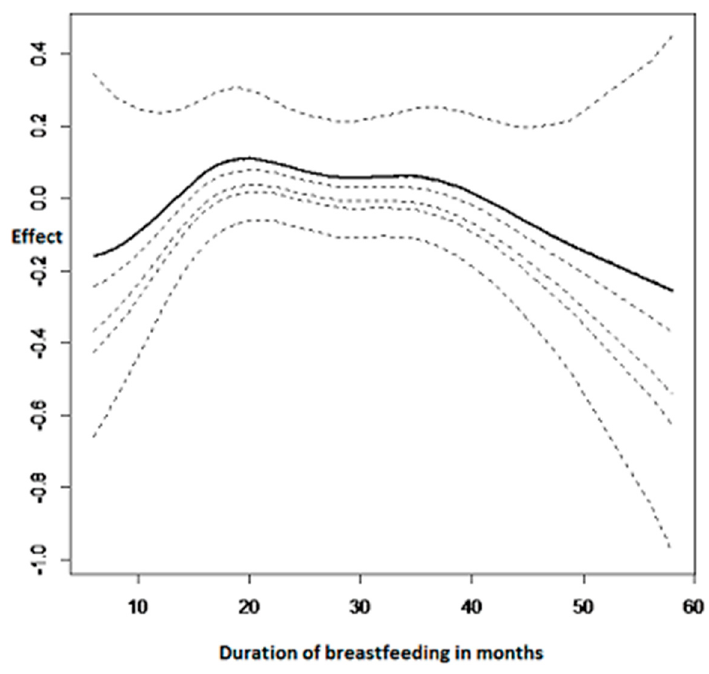
Figure 4. Nonlinear effects on childhood hemoglobin concentration: duration of breastfeeding.